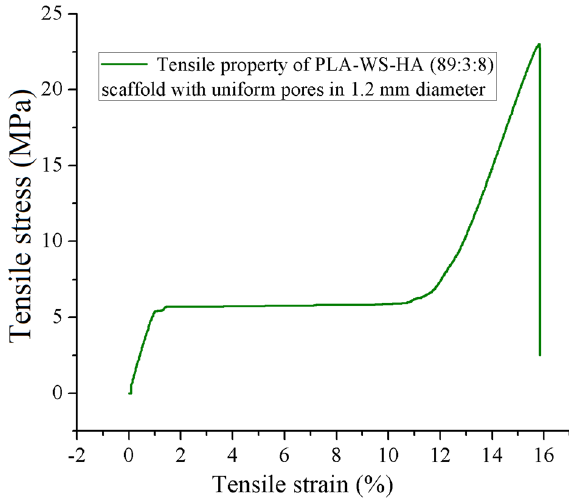
Figure 9. Tensile properties of FFF PLA-WS-HA scaffold.